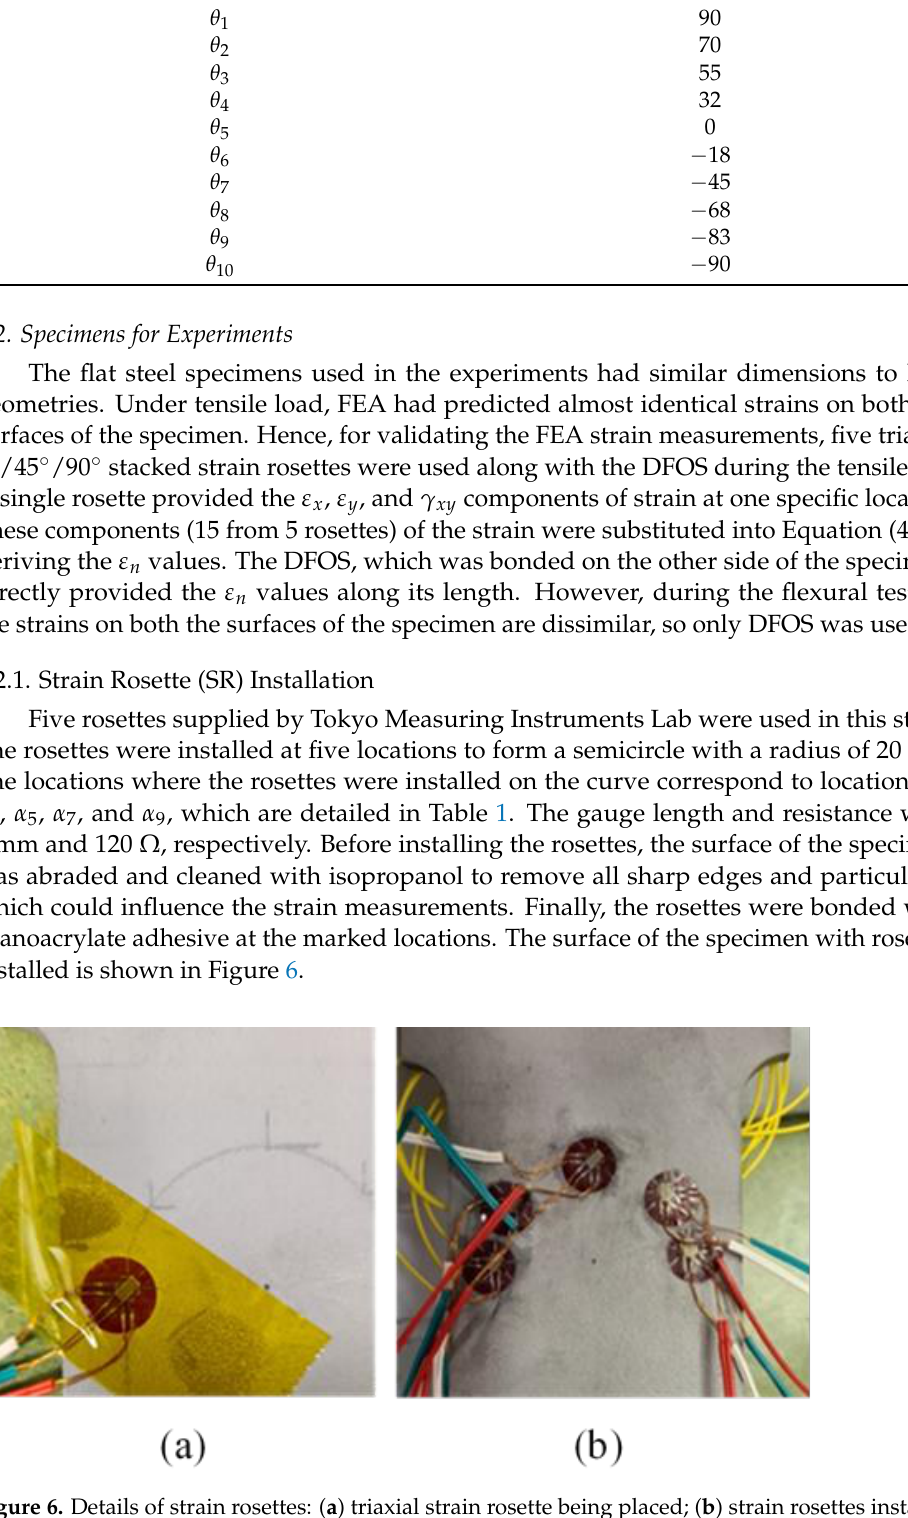
Figure 6. Details of strain rosettes: ( a ) triaxial strain rosette being placed; ( b ) strain rosettes installed on the semicircular path.